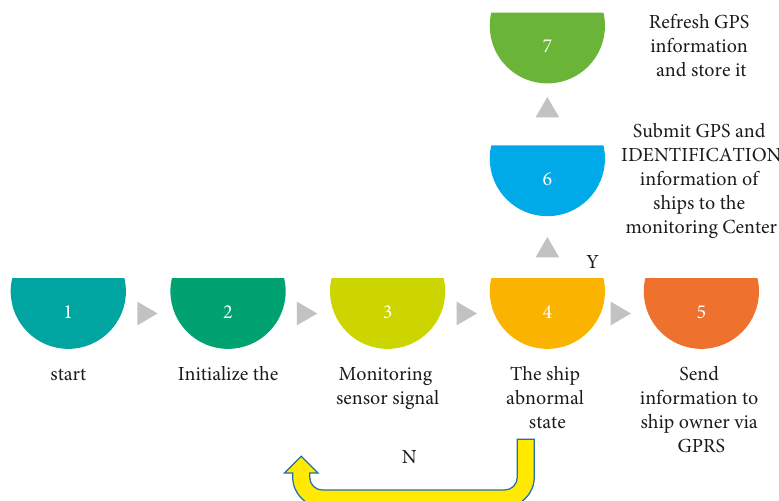
Figure 4: Flowchart of system monitoring program.